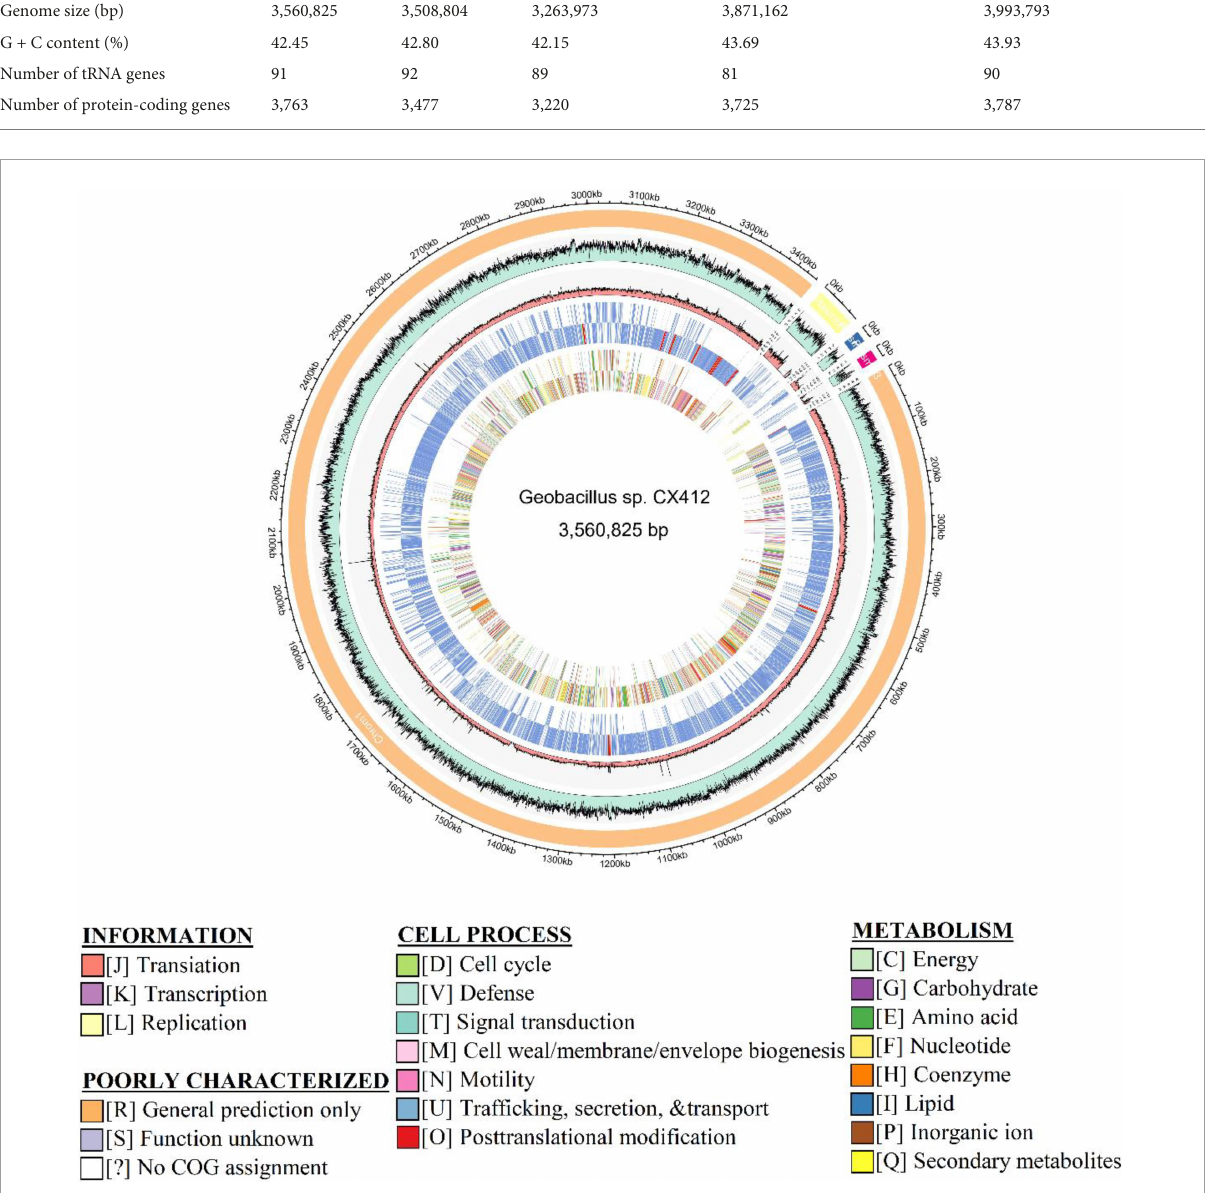
FIGURE1 Genome map of Geobacillus sp. CX412. From outer to inner: Scale marks in kb, GC%, Coverage, Gene category, and COG category,